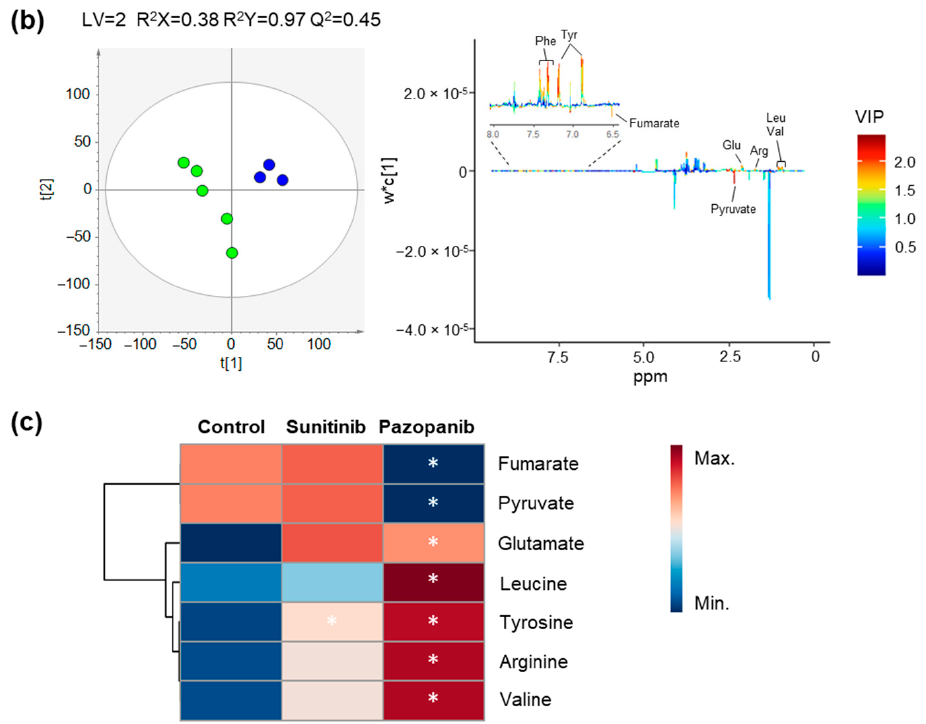
Int. J. Mol. Sci. 2022 , 23 , x FOR PEER REVIEW 10 of 21 Figure 4. Impact of TKIs on the exometabolome (extracellular metabolites present in culture medium) profile of Caki-1 cells. ( a , b ) PLS-DA scores scatter plots (left) and loading plots (right) obtained for ( a ) non-exposed cells (green circles, n = 5) vs. cells exposed to 2 µ M sunitinib (red circles, n = 4) and ( b ) non-exposed cells (green circles, n = 5) vs. cells exposed to 50 µ M pazopanib (blue circles, n = 3). ( c ) Heatmap illustrating the mean levels of metabolites changing in culture media of Caki-1 cells after exposure with 2 µ M sunitinib and 50 µ M pazopanib. Rows correspond to the mean normalized peak area of each metabolite colored from minimum value (dark blue) to maximum value (dark red), while the columns represent each sample group. The control group represented in the first column corresponds to non-exposed cells. The statistical significance was assessed by comparison with the control cells (* p < 0.05). Abbreviations: Arg—arginine, Glu—glutamate, Leu—leucine, Phe—phenylalanine, Tyr—tyrosine, Val—valine.